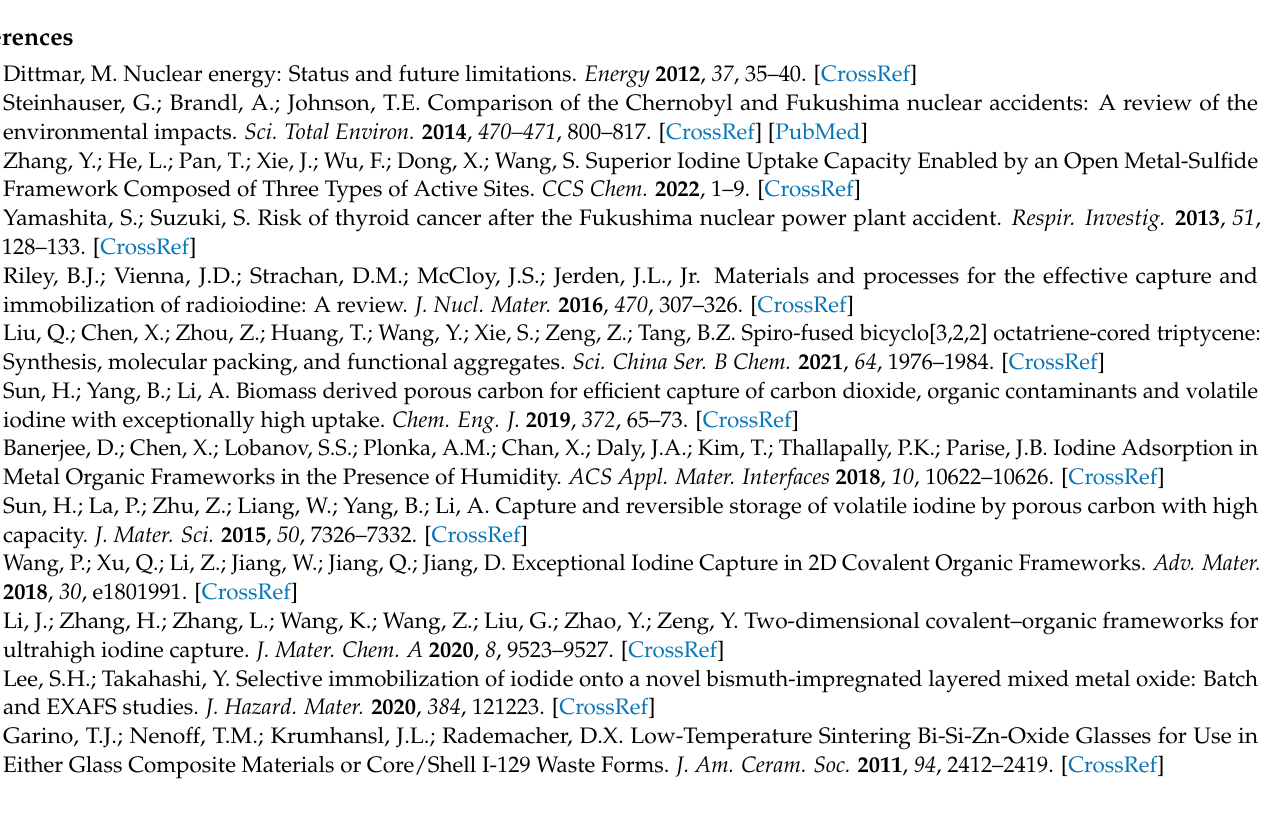
of PyT-2 with AA stacking form; Figure S2: SEM image of PyT-1; Figure S3: SEM image of PyT-2; Figure S4: TGA curve of PyT-1 (A) and PyT-2 (B) and FTIR spectra in various solvents of PyT-1 (C) and PyT-2 (D) and iodine vapor adsorption capacities of PyT-1(E) and PyT-2(F) before and after being immersed in n -hexane; Figure S5: Iodine retention of PyT-1 and PyT-2 exposure to air at 25 ◦ C and ambient pressure after iodine capture; Table S3: Summary of representatively reported adsorbents with our work for iodine solution adsorption under ambient pressure; Figure S6: Iodine adsorption capacities of PyT-1 and PyT-2 in n -hexane with iodine concentration of 200 mg L − 1 (B); Table S4: Kinetic parameters for the volatile iodine adsorption onto PyT-1 and PyT-2; Figure S7: (A) UV–vis spectra for PyT-1 in 400 mg L − 1 of iodine in n -hexane solution at different times; (B) UV–vis spectra for PyT-2 in 400 mg L − 1 of iodine in n -hexane solution at different times; (C) UV–vis spectra for PyT-1 in 200 mg L − 1 of iodine in n -hexane solution at different times; (D) UV–vis spectra for PyT-2 in 200 mg L − 1 of iodine in n -hexane solution at different